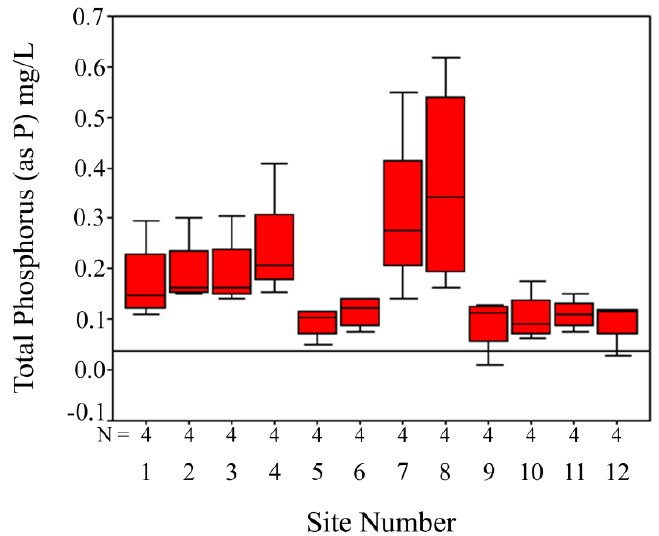
Figure 3. Box plot of total phosphorus (TP) concentrations (as P) in mg/L by site (4 samples/site) in the Little Choctawhatchee River watershed from October 2007 to June 2008. Reference line indicates U.S. EPA suggested criteria for TP as P (0.0365 mg/L as